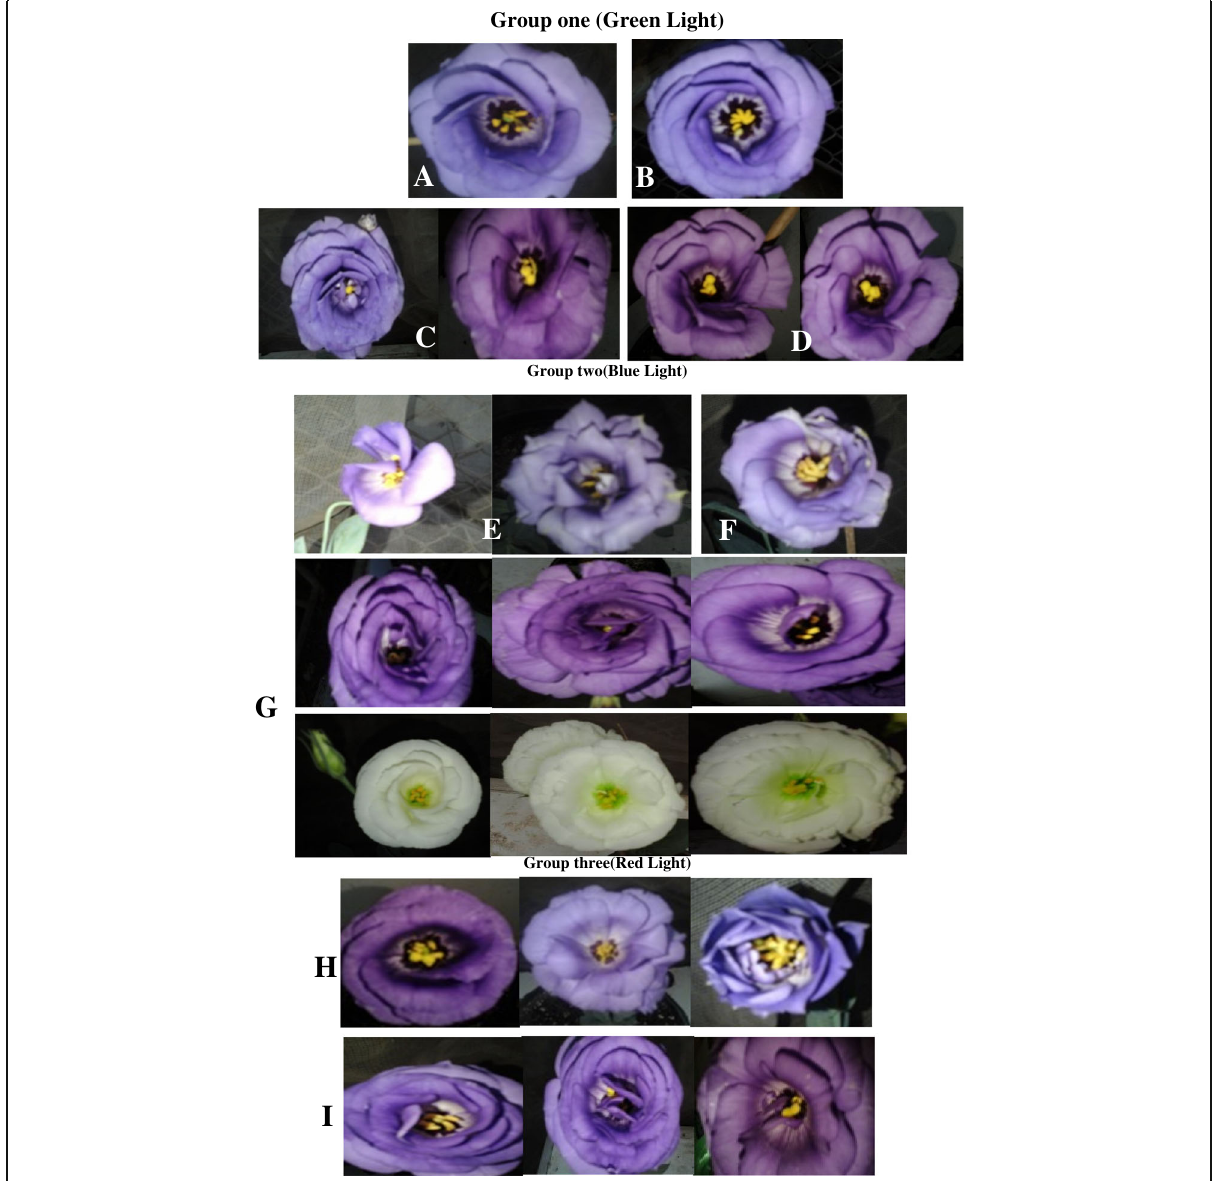
Fig. 1 Changes in Eustoma grandiflorum flowers color and form after radiation with different doses of laser radiation. a Control (untreated plants), b 10 min green light, c 20 min green, d 25 min green, e 5 min blue, f 10 min blue, g 20 min blue, h 20 min red light, and i 25 min